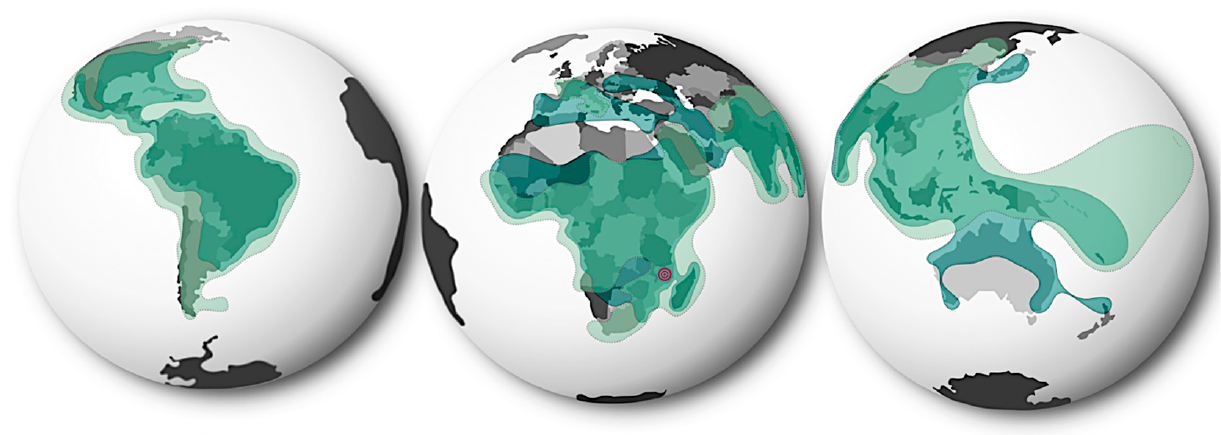
Figure 1. Overlapping distribution of the Chikungunya virus and the probability of occurrence of Aedes mosquitos ( A. aegypti and A. albopictus ). Originally identified in Tanzania in 1952 (red), CHIKV has been reported in over 100 countries in Africa, Asia, the Pacific, Oceania, the Americas, and the Caribbean (light green). The expansion of CHIKV’s geographical distribution across the globe has been perpetuated by the presence of Aedes mosquitos in non-endemic regions. The widespread distribution of CHIKV’s most common vectors ( A. aegypti and A. albopictus ) puts half of the world’s population at risk of infection (dark green).